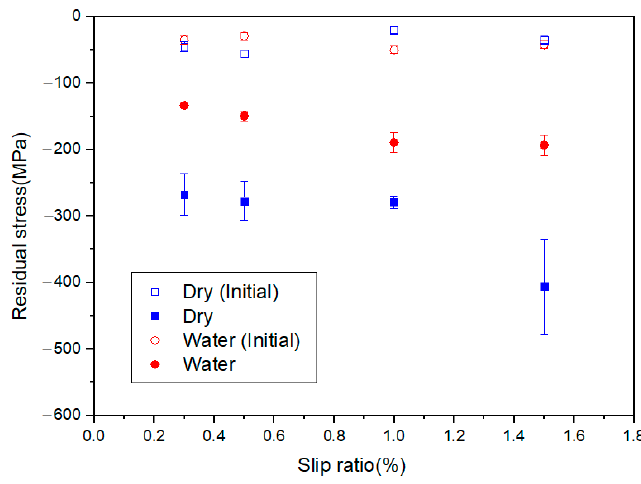
Figure 27. Residual stress variation according to slip ratio.